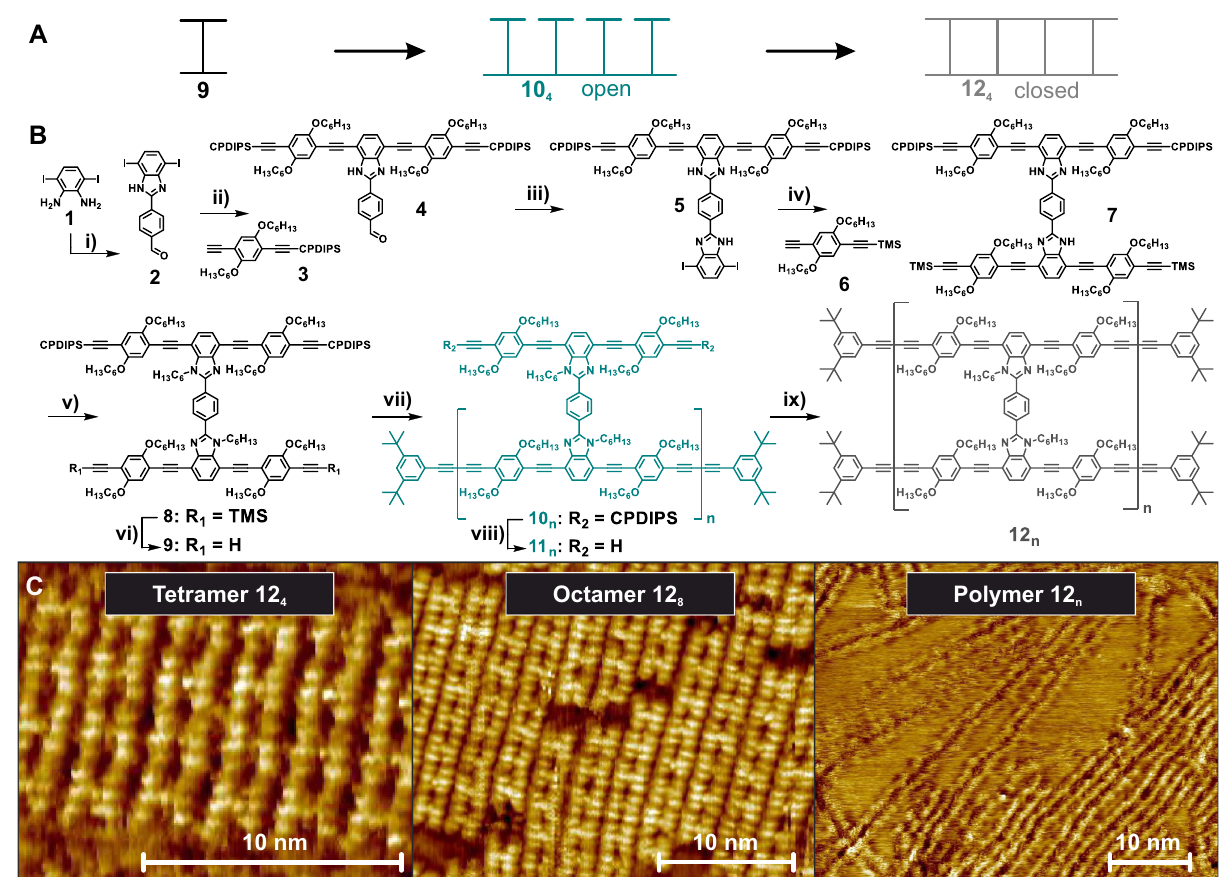
Fig. 1 Oligomers and polymers of π -conjugated ladders. A Schematic representation of the ladder monomer 9 , and the open ( 10 ) and closed ( 12 ) oligomers. B The fi rst steps of the synthesis by Sonogashira coupling involves the creation of “ H ” -shaped molecules ( 1 – 9 ). 9 is then used for polymerization by Glaser coupling, resulting in the oligomeric structures 10 n with n = 4, 8, and ≈ 40 for tetramers, octamers and polymers. After removal of the CPDIPS- protecting groups, an intramolecular zipping reaction under Glaser coupling conditions leads to the ladder structures 12 n . i) Terephthalaldehyde, ZrCl 4 , CHCl 3 , r.t., 16 h, 49%, ii) 3 , PdCl 2 (PPh 3 ) 2 , CuI, PPh 3 , THF, piperidine, r.t., 3 d, 55%; iii) 1 , ZrCl 4 , CHCl 3 , r.t., 15 h; iv) 6 , PdCl 2 (PPh 3 ) 2 , CuI, PPh 3 , THF, piperidine, r.t., 2 d, 57% for two steps; v) 1-iodohexane, K 2 CO 3 , acetone, r.t., 2 d, 93%; vi) K 2 CO 3 , MeOH, CH 2 Cl 2 , 40 °C, 5 h, 99%; vii) oligomerization: 1) CuCl, CuCl 2 , CH 2 Cl 2 , pyridine, 25 °C, 3 h, 2) 3,5-di- tert -butyl phenylacetylene, 16 h, 4.5% ( 10 4 ), 4.3% ( 10 8 ); polymerization: 1) CuCl, CuCl 2 , CH 2 Cl 2 , pyridine, 25 °C, 16 h, 2) 3,5-di- tert -butyl phenylacetylene, 5 h, 2.8% ( 10 n ); viii) Bu 4 NF, CH 2 Cl 2 , THF, 35 °C, 1 to 3 h; ix) 1) CuCl, CuCl 2 , pyridine, 35 °C, 25 to 45 min, 2) 3,5-di- tert -butyl phenylacetylene, 15 to 17 h, 59% ( 12 4 ), 54% ( 12 8 ), 23% ( 12 n ) for two steps. ( C ) STM images of the ladder molecules 12 on graphite (image sizes: 14.9 × 12.0 nm 2 , 29.9 × 23.6 nm 2 , and 50.0 × 39.0 nm 2